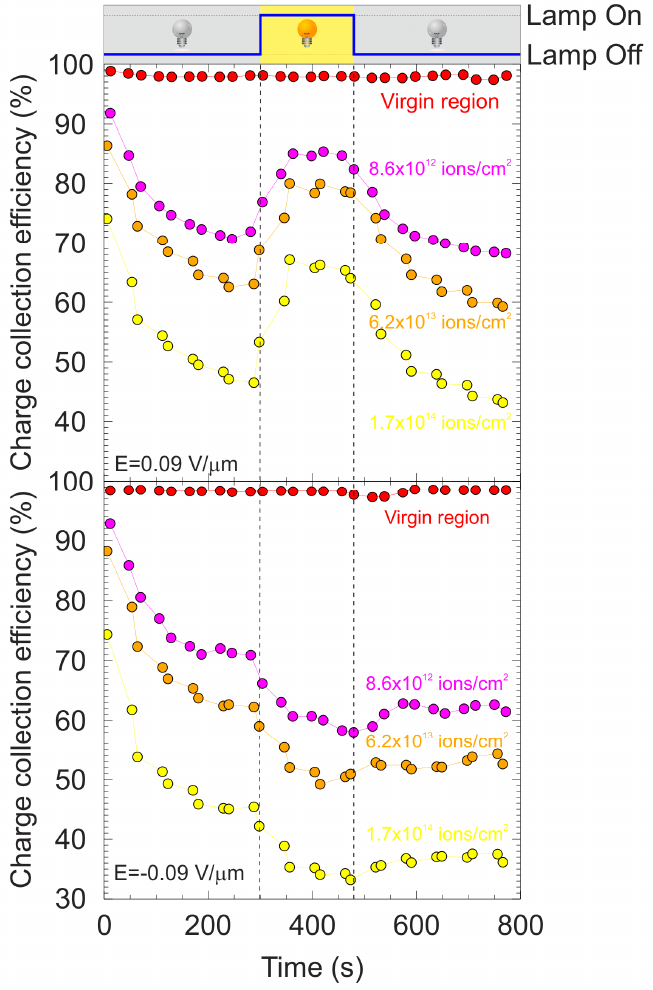
Figure 13. Temporal evolution of CCE for the different ROIs defined in the damaged regions for positive bias ( middle ) and for negative bias ( bottom ). The chronogram ( top ) indicates the applied illumination cycle.